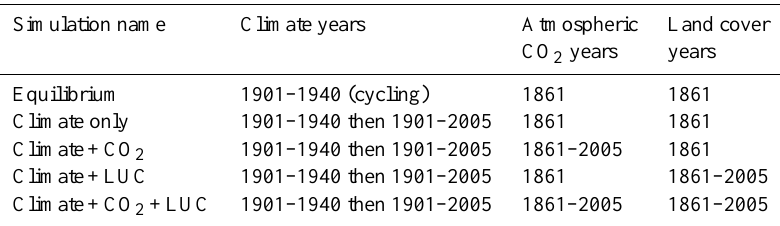
Table 1. CLASS-CTEM simulations performed for the composite and mosaic configurations. For the transient simulations (last four listed below), the simulation years of 1861–1900 were forced with climate from 1901 to 1940; simulation years 1901–2005 were forced with climate years from 1901 to